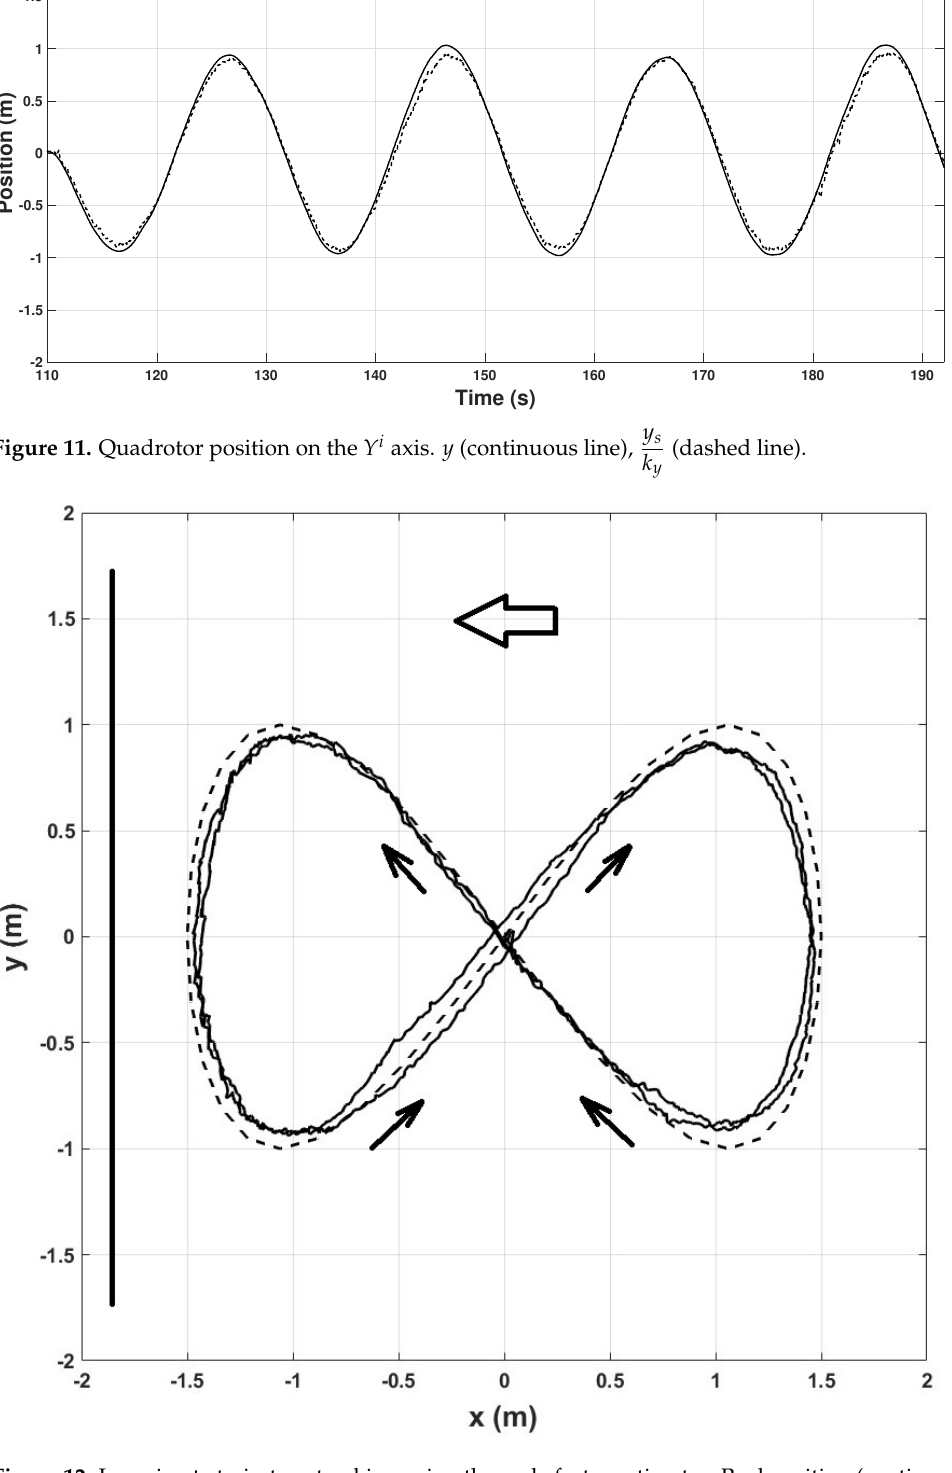
Figure 12. Lemniscate trajectory tracking using the scale factor estimator. Real position (continuous line), desired position (dashed